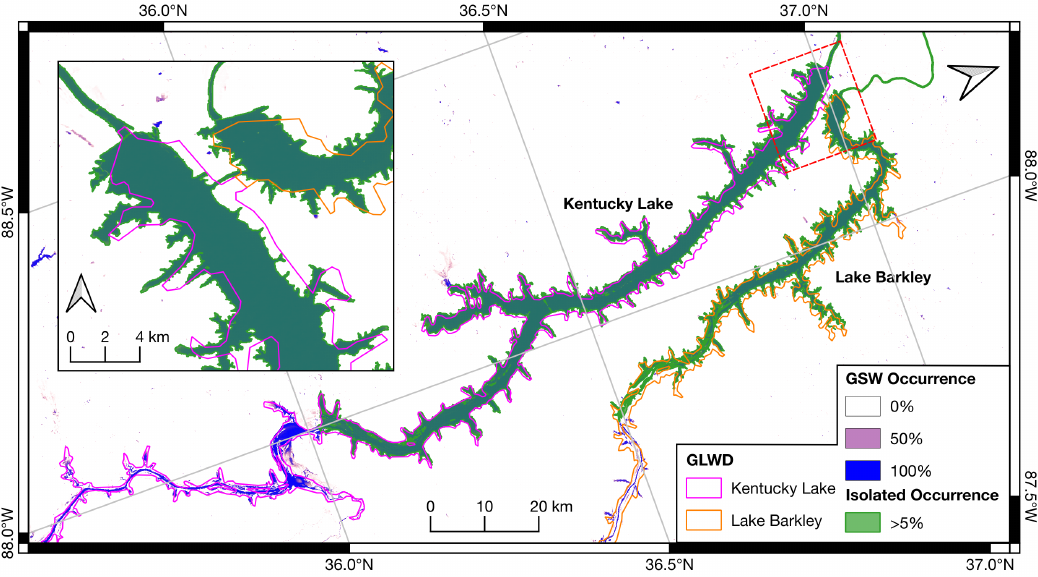
Figure 7. Lake Barkley and Kentucky, separated in the GLWD data (purple and orange) and merged in the isolated results of this study (green). Additionally, the GSW water occurrence is shown as a background. The inset shows the area close to the dams and the Barkley Canal connecting both